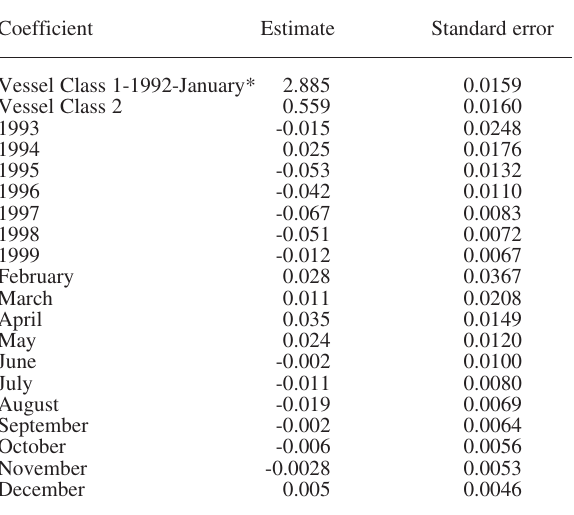
T ABLE 3. – Analysis of deviance results for GLM fitted to red shrimp trawl catch rate data from the period 1992-1998 in the port of Santa Pola. Coefficients express the difference between each level of the factors at the first level (*).